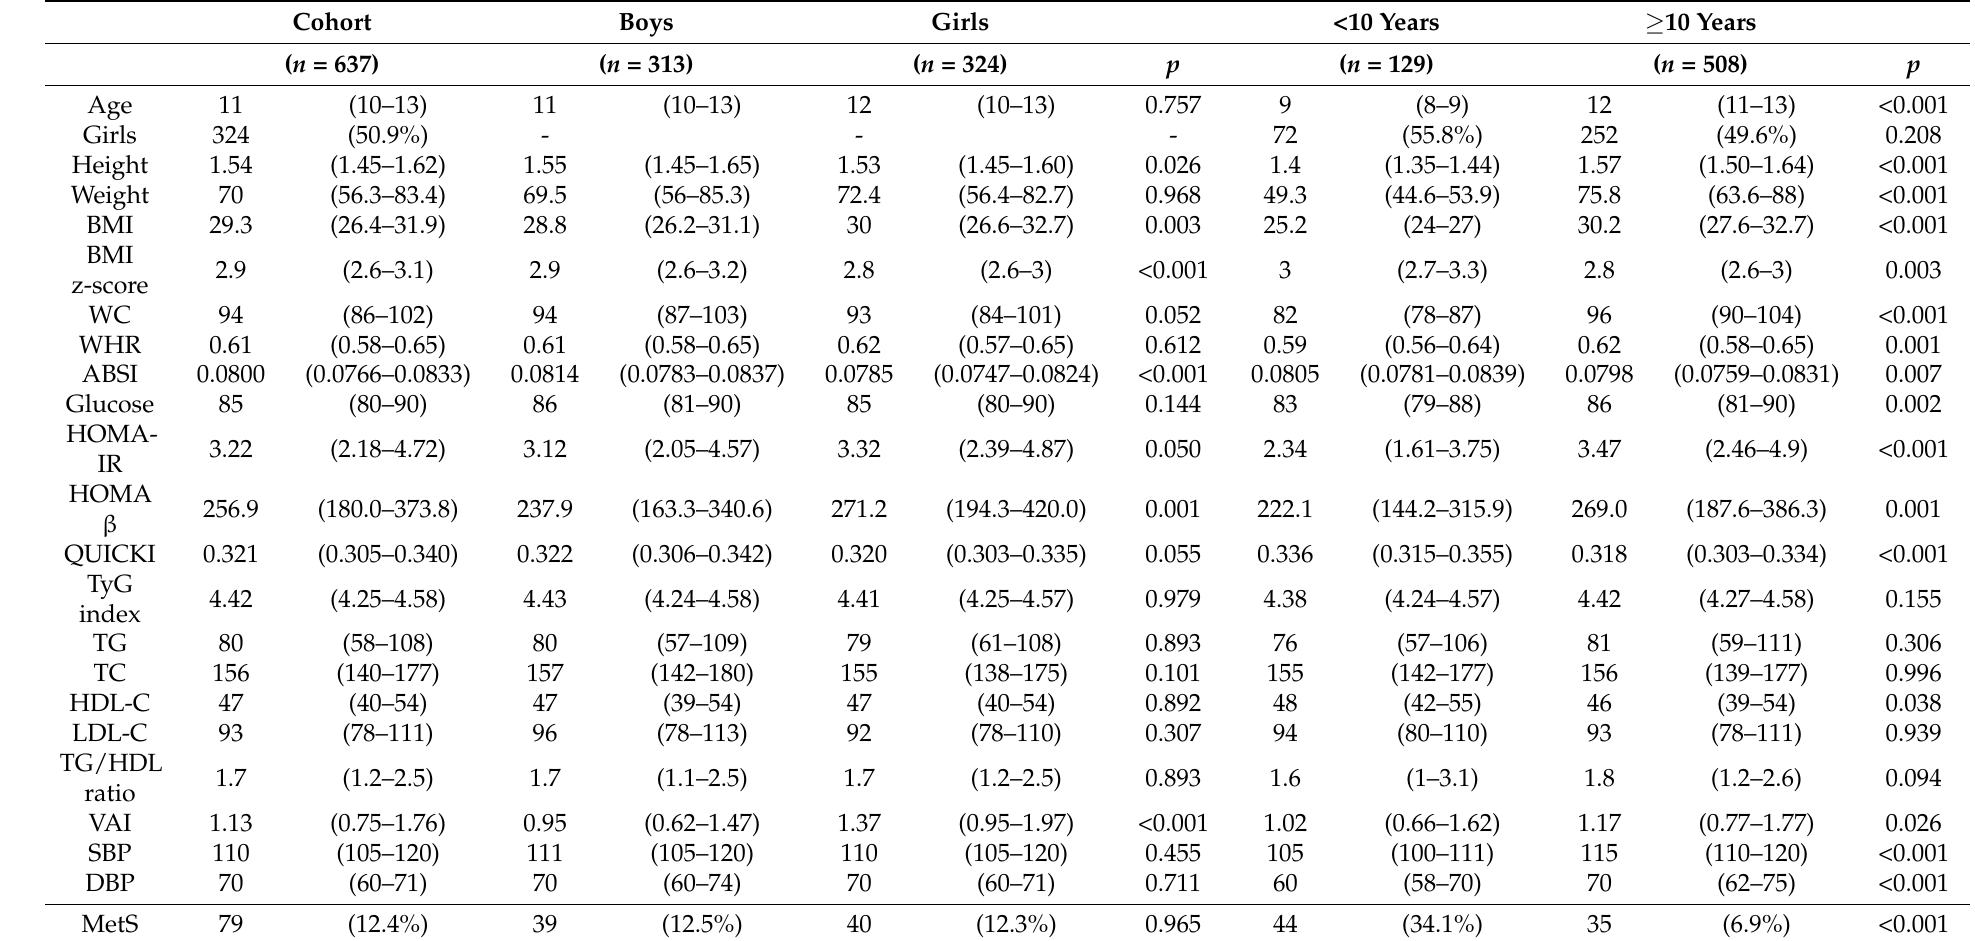
Table 1. Characteristics of the population according to gender and age